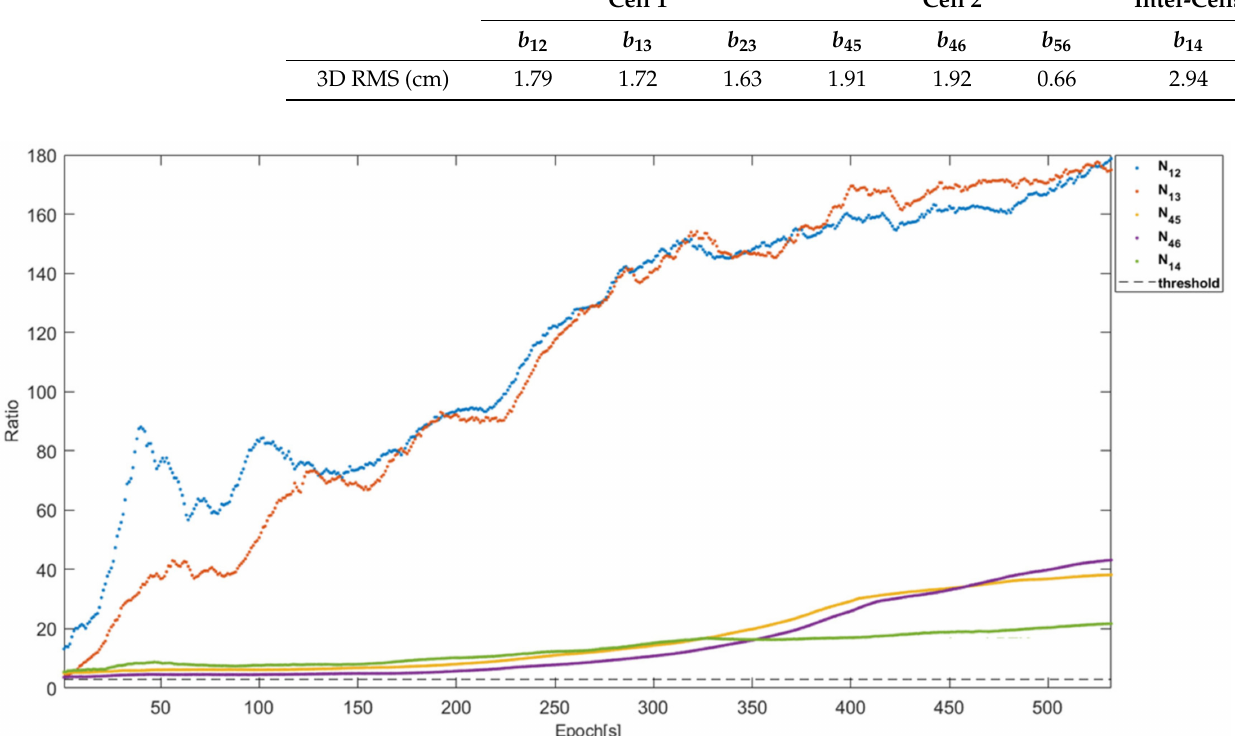
Figure 18. The ratio test results of N 12 , N 13 , N 43 , N 45 , and N 14. All ratios are greater than three from the first